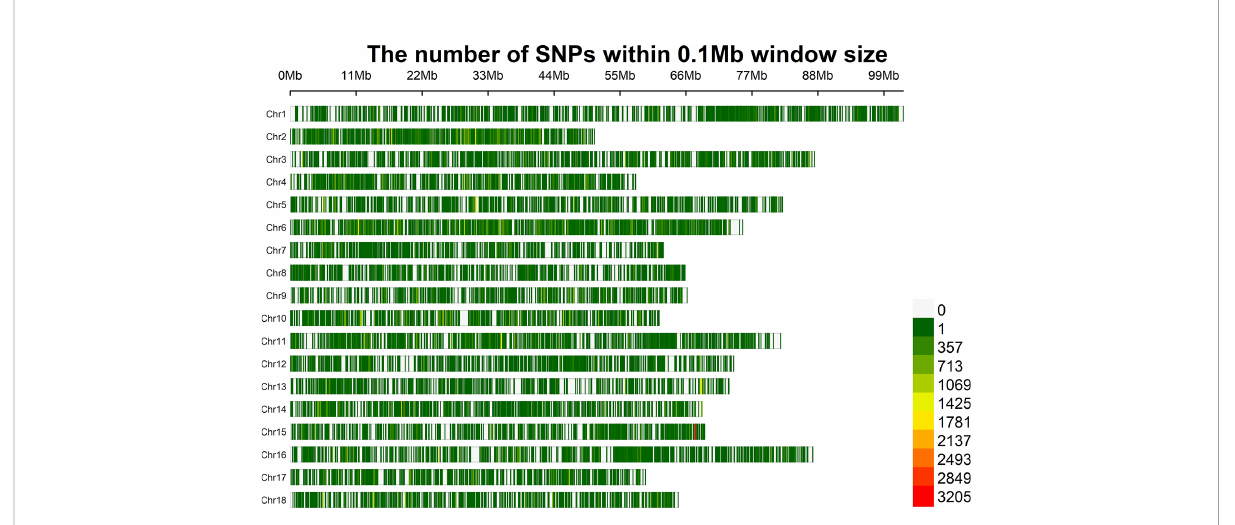
FIGURE 3 Distribution of SNPs on each chromosome (the number of SNPs within 0.1 Mb window